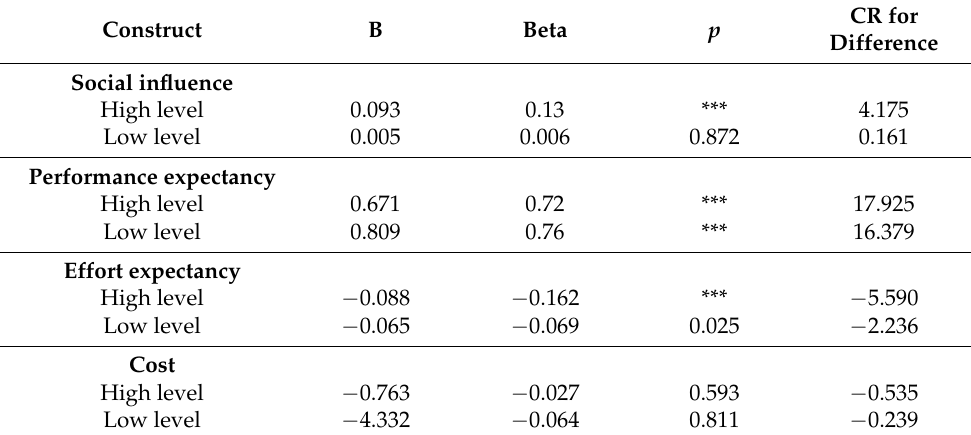
Table 7. Moderation test of the effect of awareness on the relationship between intention and construct variables.